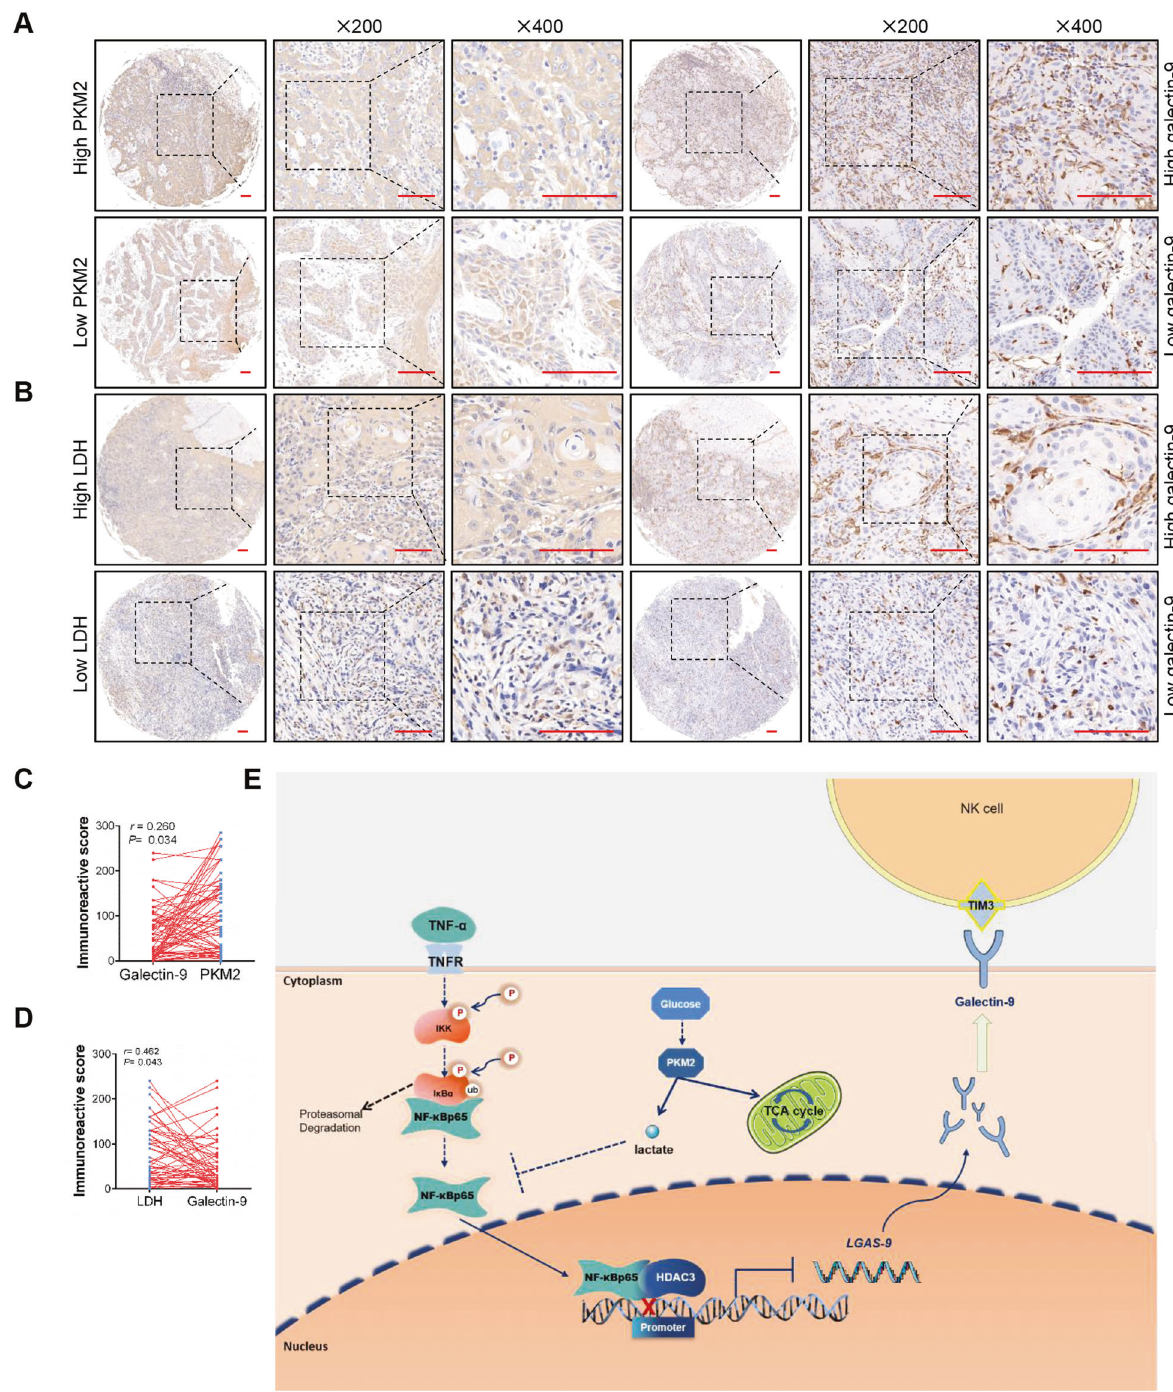
Fig. 7 Overexpression of PKM2 correlates with Galectin-9 expression in HNSCC tissues. A , B Representative immunohistochemistry images of PKM2, Galectin-9, and LDH in HNSCC tissues were shown. C , D Correlation between PKM2, LDH, and Galectin-9 expression was analyzed in HNSCC patients. E Schematic diagram showed that lactate secreted by PKM2 upregulation promoted Galectin-9-mediated immunosuppres- sion through inhibiting NF- κ B pathway in HNSCC. Bar: 50 μ m * P < 0.05, ** P < 0.01. level of Galectin ‑ 9 correlated with pathological grade (Fig. S15, P detected in paired HNSCC tissues. A positive correlation between = 0.0012), but there was no correlation between Galectin ‑ 9 PKM2 and Galectin-9 expression was observed in HNSCC tissues expression and other factors, including advanced TNM stage, (Fig. 7A, C). Moreover, there was also a positive correlation gender, and age (Fig. S19). LDH is essential for the conversion of between PKM2 and other immunosuppression-related molecules, pyruvate into lactate. A positive correlation between LDH and CD274 (encoding PD-L1), HLA-E and FGL1 in HNSCC datasets (Fig. PKM2 and Galectin ‑ 9 was observed in the HNSCC tissues (Figs. 7B, S19). Moreover, the IRS of Galectin-9 and LDH in HNSCC patients D and S21). To sum up, this study demonstrates that PKM2- was higher than that in normal controls (Fig. S20). The expression Cell Death and Disease (2021)